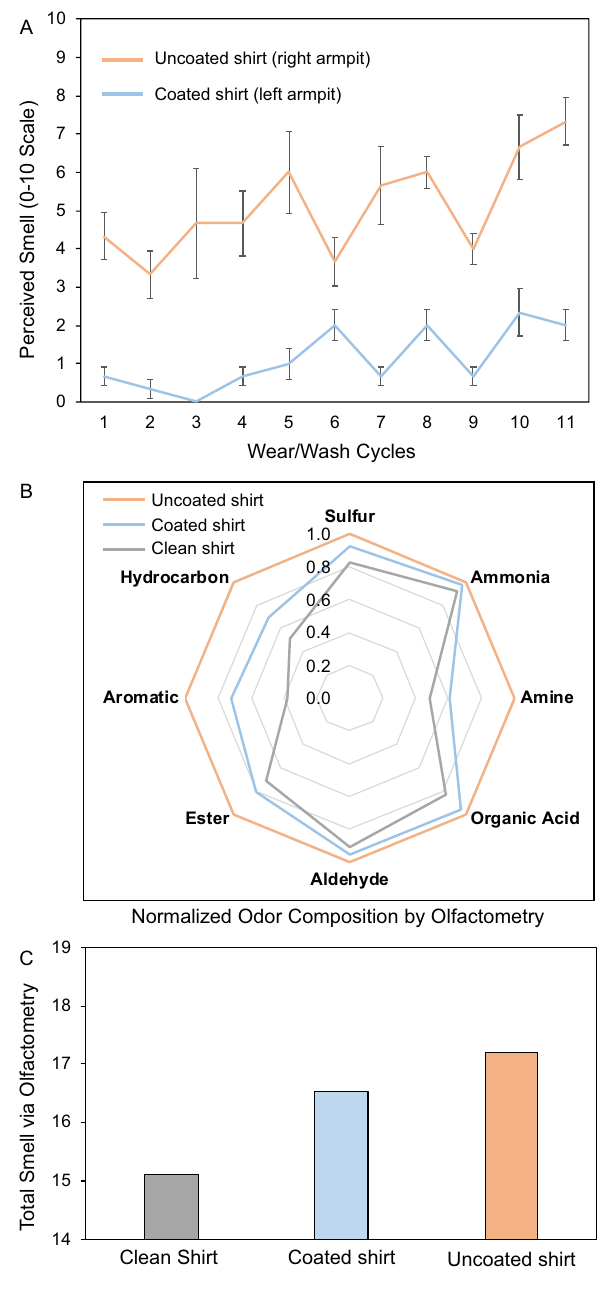
Figure 4. Odor prevention of Ag/TA coatings on clothes after a full day of wear. ( A ) Coatings were only applied once, and then the clothes were worn normally, and machine washed and dried normally. Note the average daily temperature increased over the lifetime of the experiment. ( B ) Normalized odor composition of fabric from the same shirt before wear (clean shirt) and after wearing (Ag/TA-coated left armpit and uncoated right armpit) as measured by olfactometry. Note that the shirt was composed of synthetic fibers, was purchased new and washed once before collecting the samples. ( C ) Total strength of the overall smell from each sample in ( B